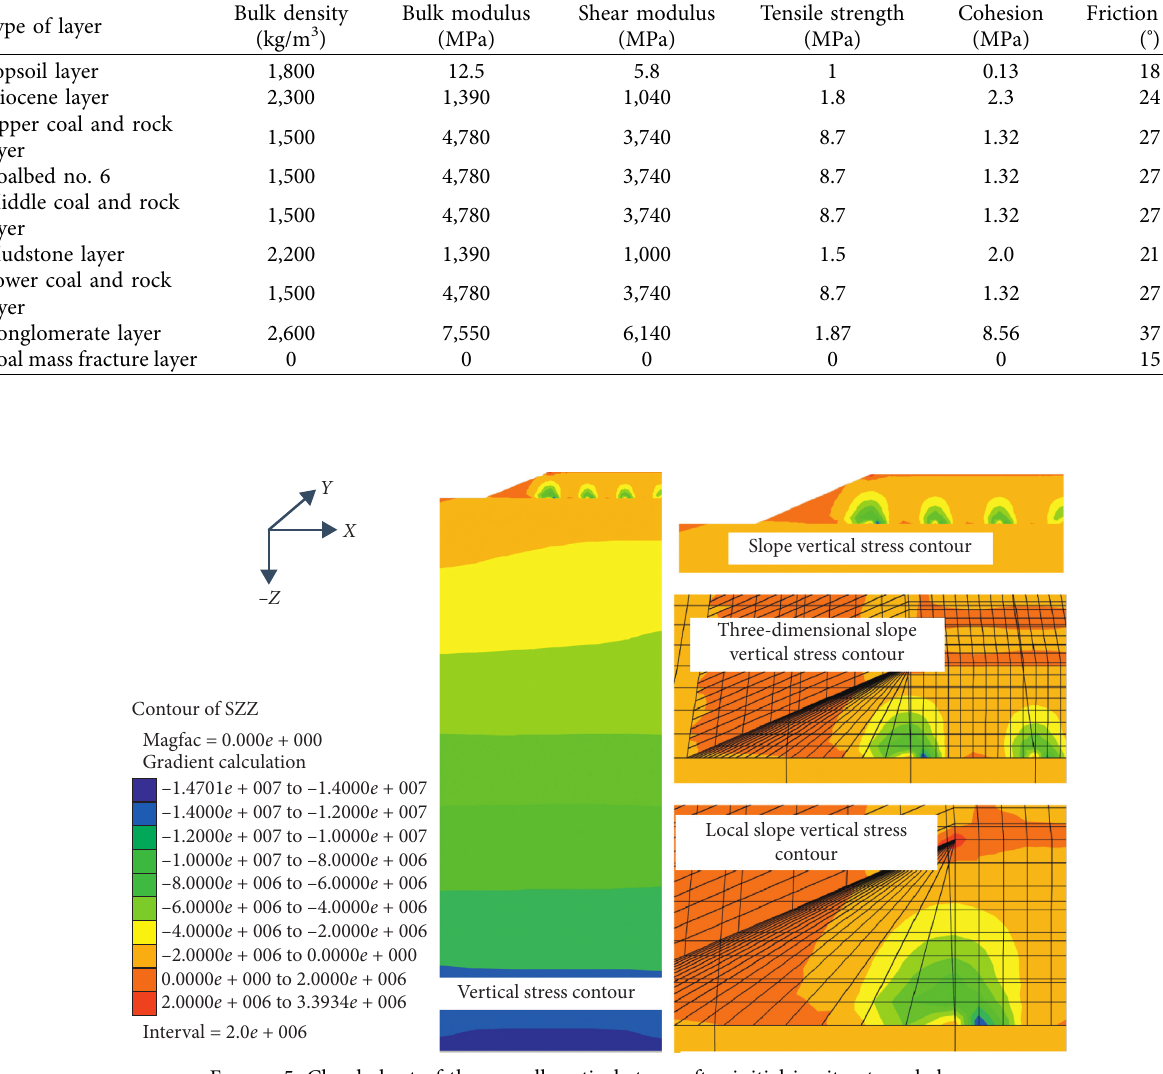
Table 4: Material parameters of the geological model.